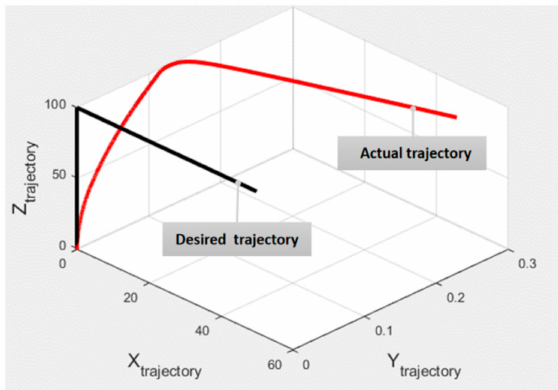
Figure 15. Trajectory tracking of hybrid VTOL vehicle.